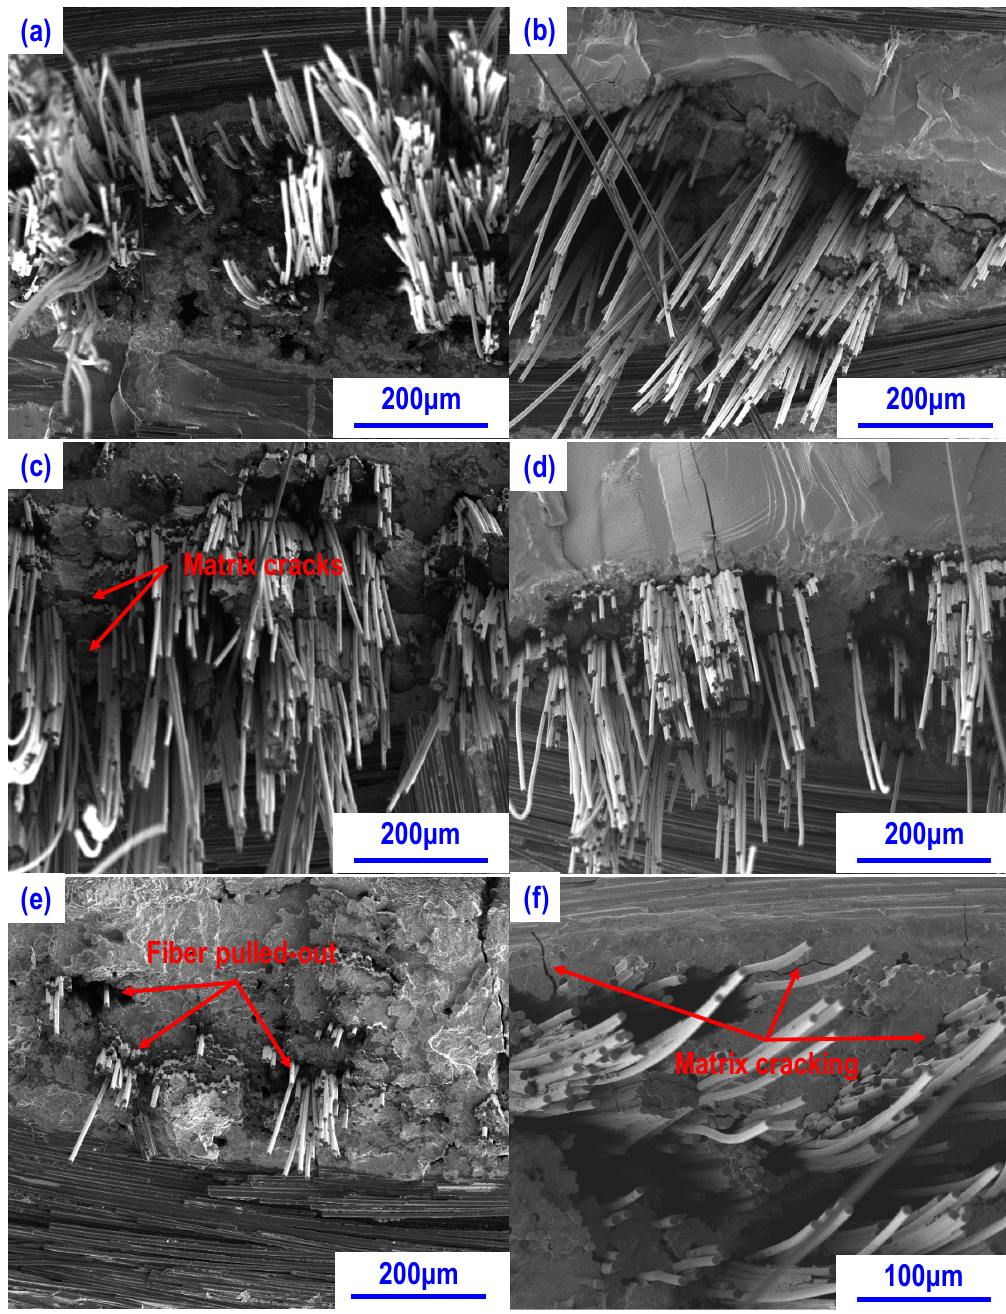
Figure 8. Morphologies of fracture surfaces at elevated temperatures: ( a ) CSZ0 at 800 °C; ( b ) CSZ10 at 800 °C; ( c ) CSZ0 at 1200 °C; ( d ) CSZ10 at 1200 °C; ( e ) CSZ0 at 1600 °C; ( f ) CSZ10 at 1600 °C.